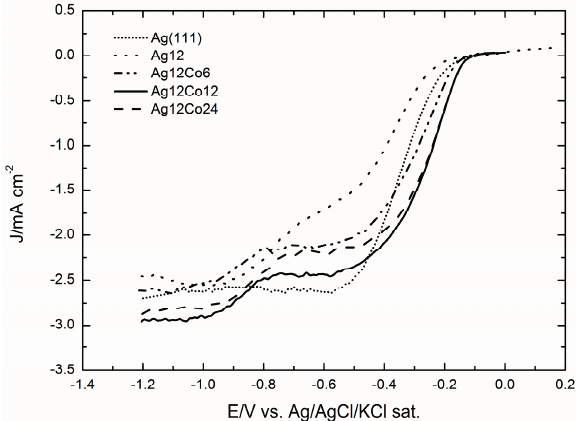
Figure 7. Comparison between the oxygen reduction reaction (ORR) on the Ag(111) electrode and on the GC/Ag12 electrode [31] and the GC electrode covered by an increasing amount of Co recorded at 500 rpm and with a scan rate of 50 mV·s − 1